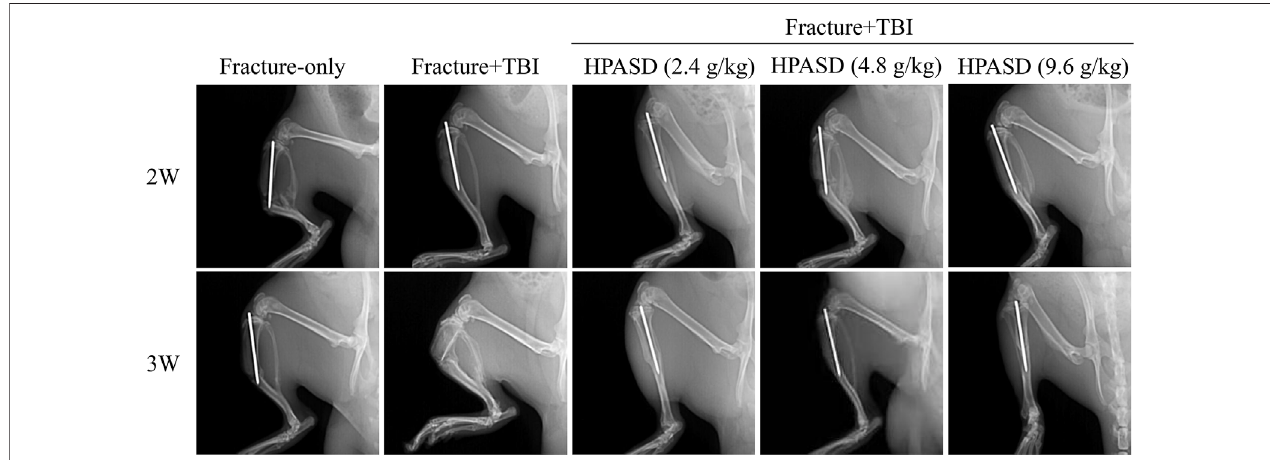
FIGURE 3 | HPASD accelerated fracture healing in the rat model of traumatic brain injury. Representative X-ray images were used to show fracture healing in rats with traumatic brain injury (TBI) in the second and third weeks after HPASD treatment.